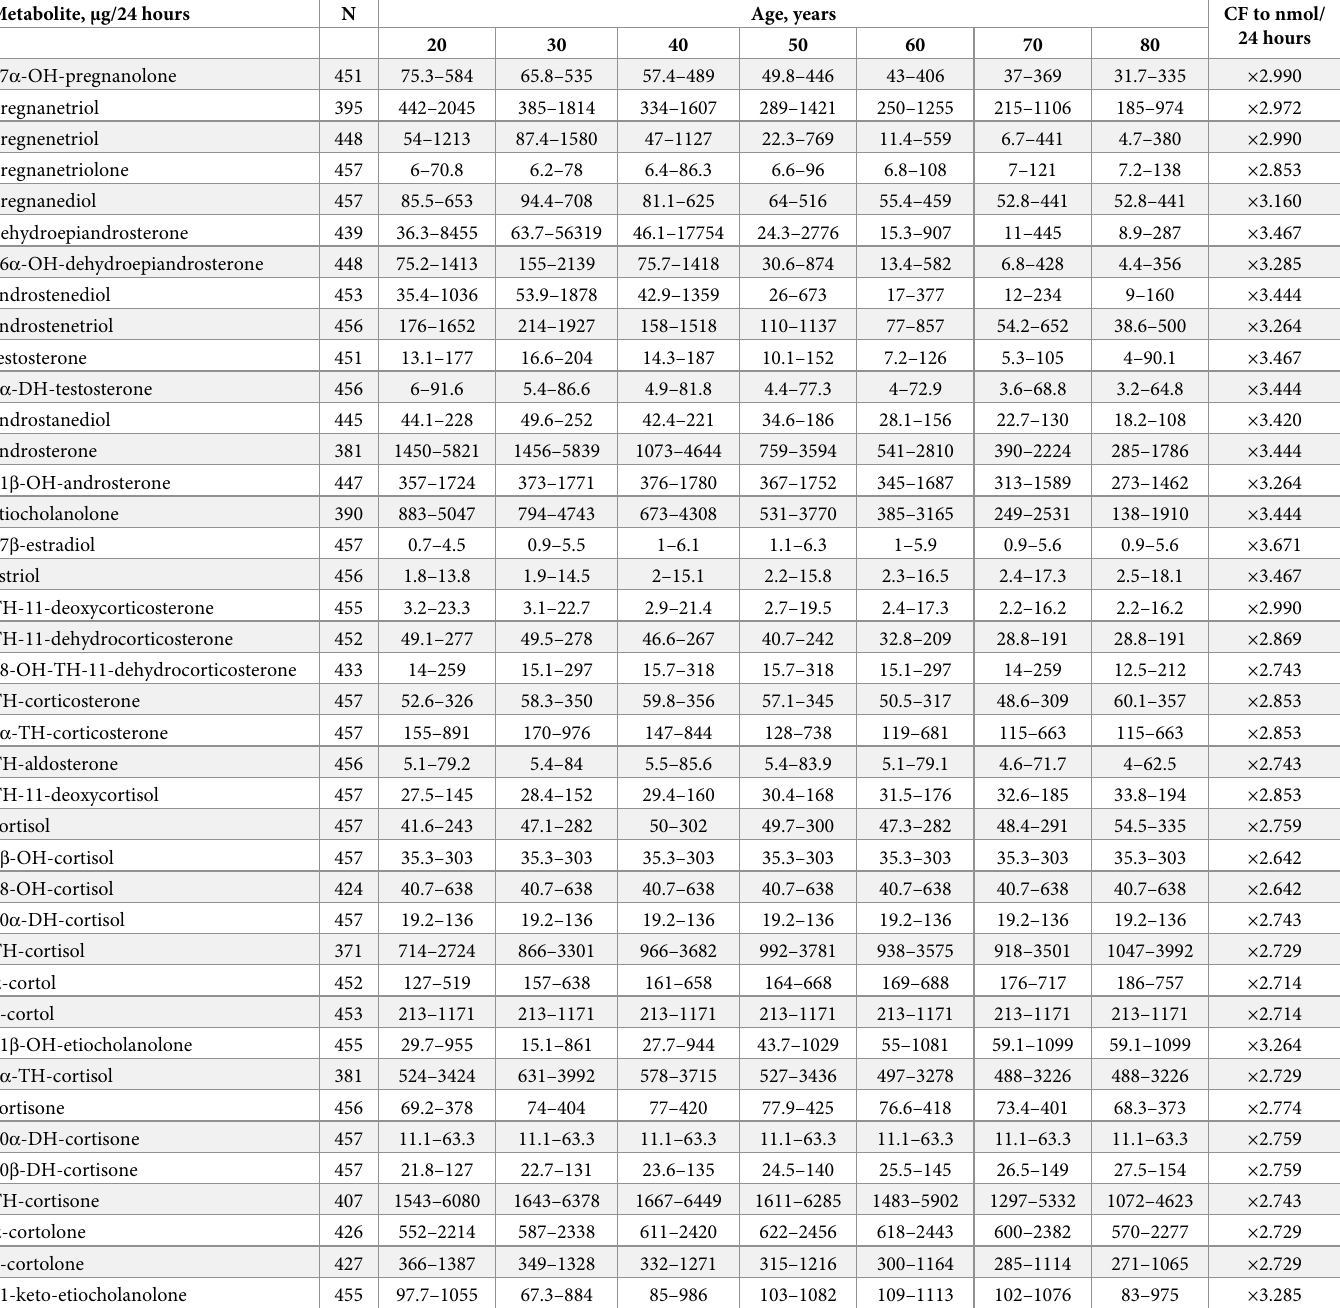
Table 2. Reference intervals for 40 steroid metabolites in 24-hour urine in